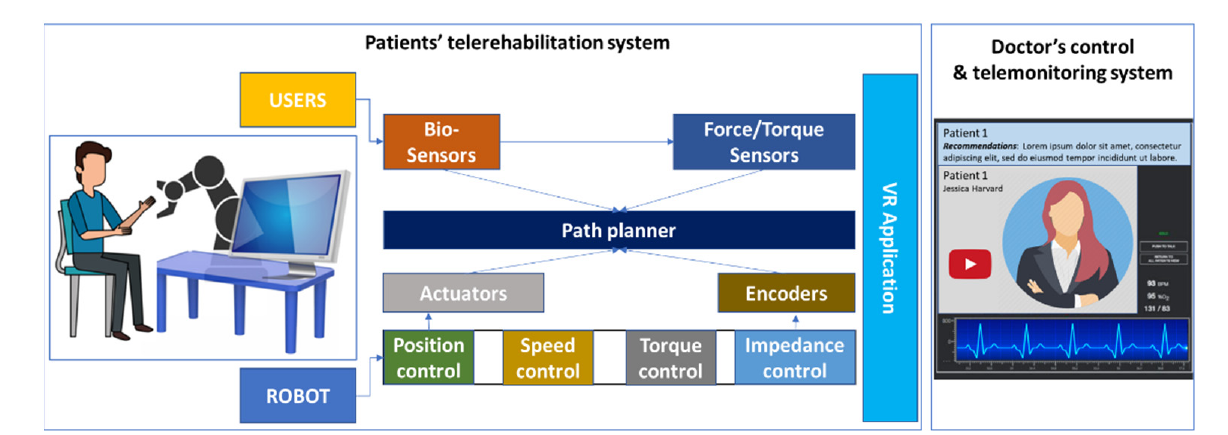
Figure 3. RoboTeleRehab control strategy—robotic system control loop.